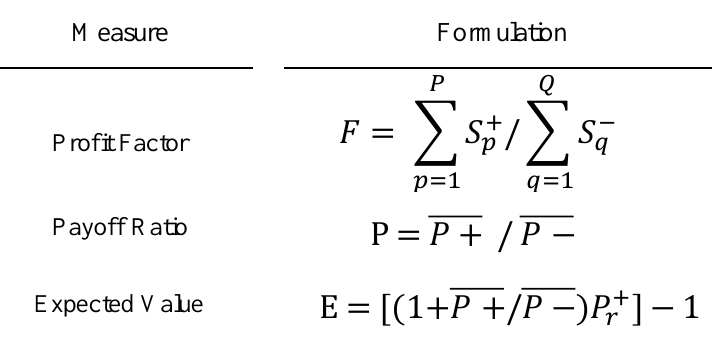
Figure A3. Profit performance metrics.